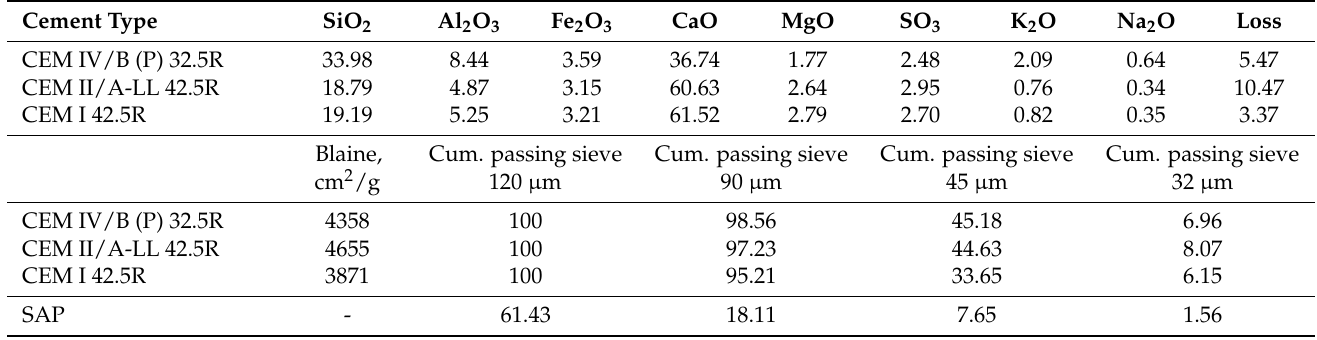
Table 1. Cement’s and SAP’s properties.